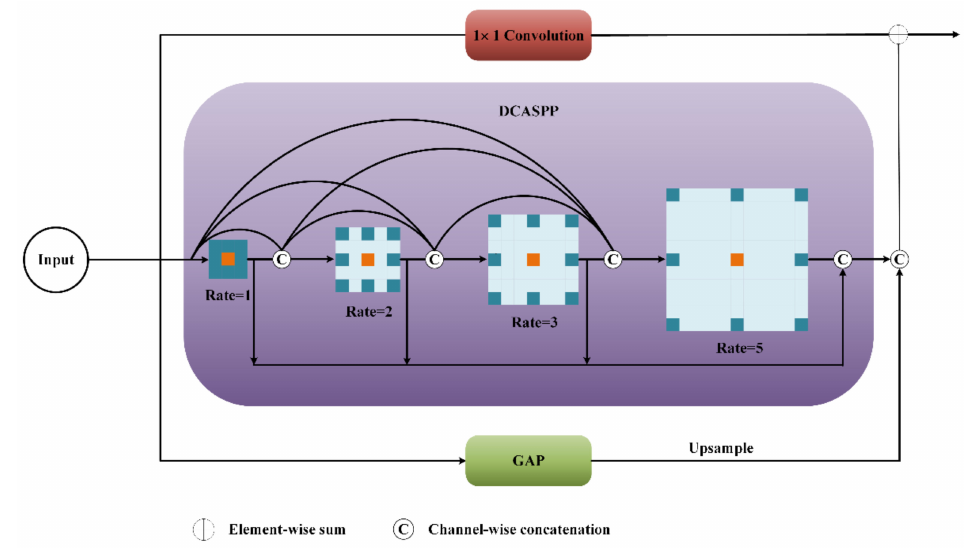
Figure 9. The structure of the Spatial Enhancement (SE)